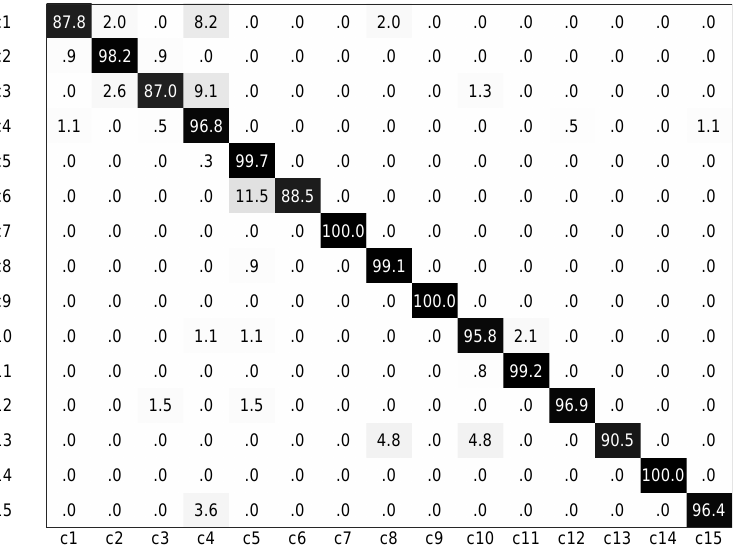
Figure 13. Confusion matrix result of our method on Turkey Plant